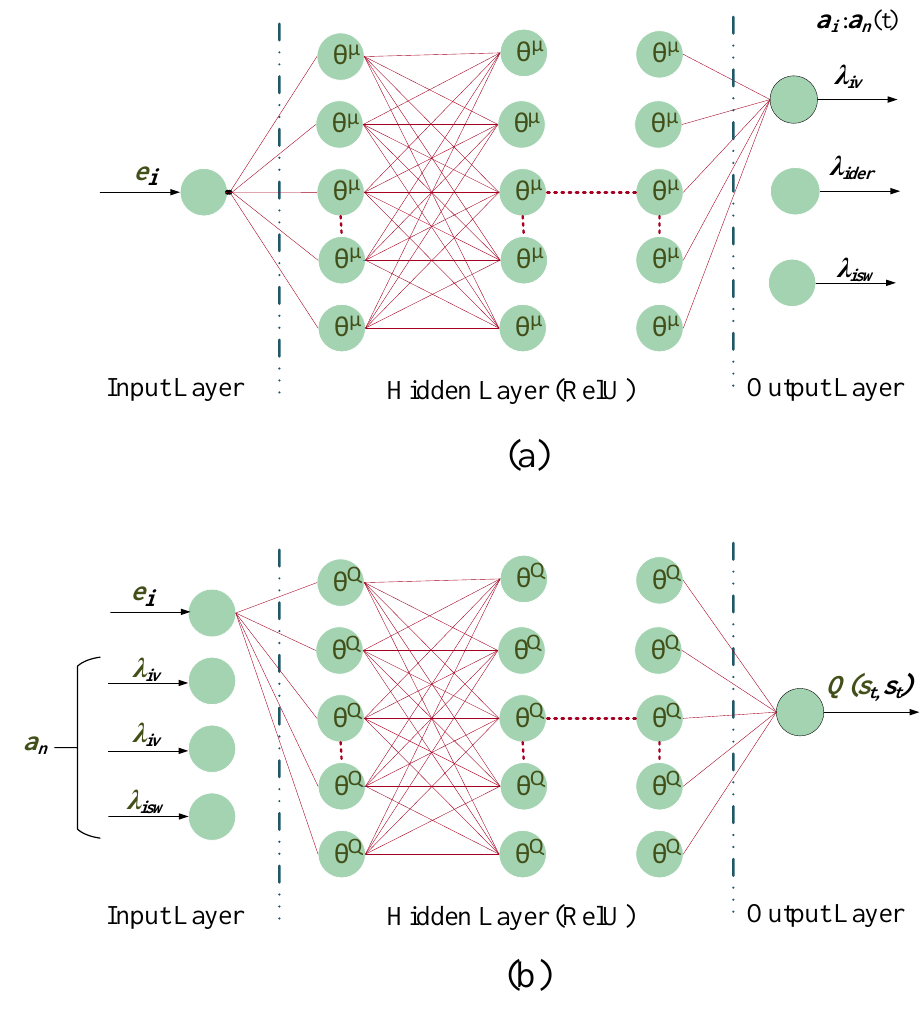
Figure 4. Illustration of the ( a ) actor-network ( b )